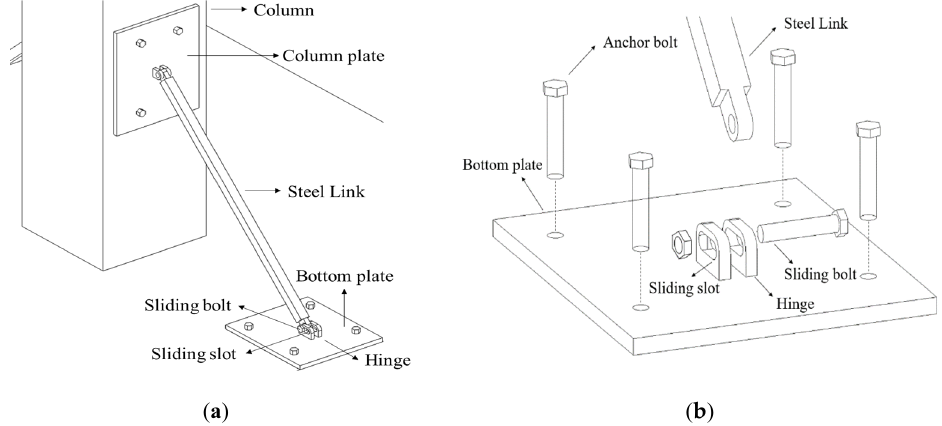
Figure 1. Scheme of the replaceable steel link (RSL) system: ( a ) applications of RSL; ( b ) components of the RSL system . of the RSL